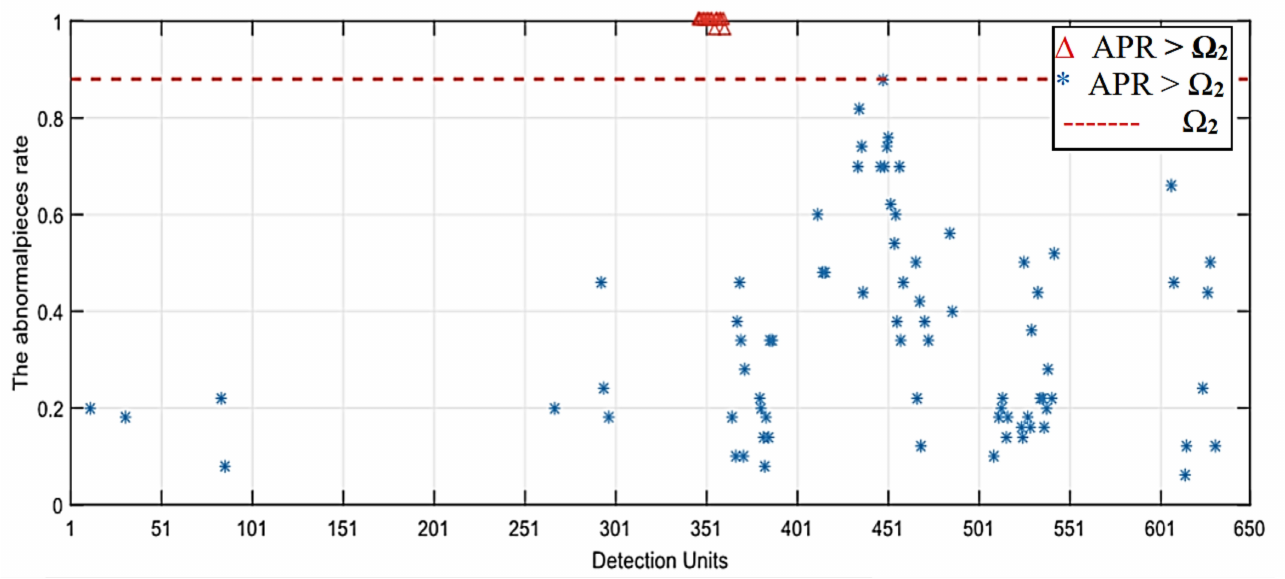
Figure 7. Results based on the abnormal pieces analysis method.